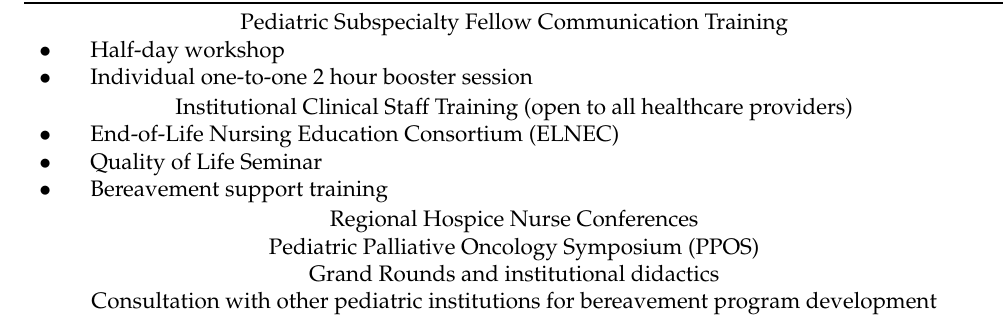
Table 2. Bereaved Parents Serve as